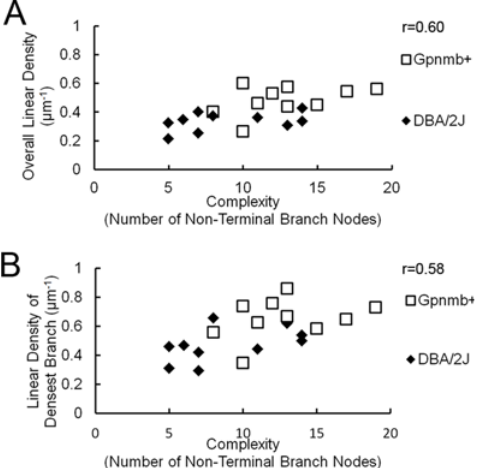
Fig 5. Correlation of synaptic density with complexity of the dendritic arbor in glaucomatous DBA/2J and control D2.Gpnmb+ retinas. A, Scatterplot of overall linear density of PSD-95 puncta reveals a weak correlation with the complexity of the dendritic arbor as measured by the number of non-terminal nodes. B, the correlation was repeated for the densest branch.